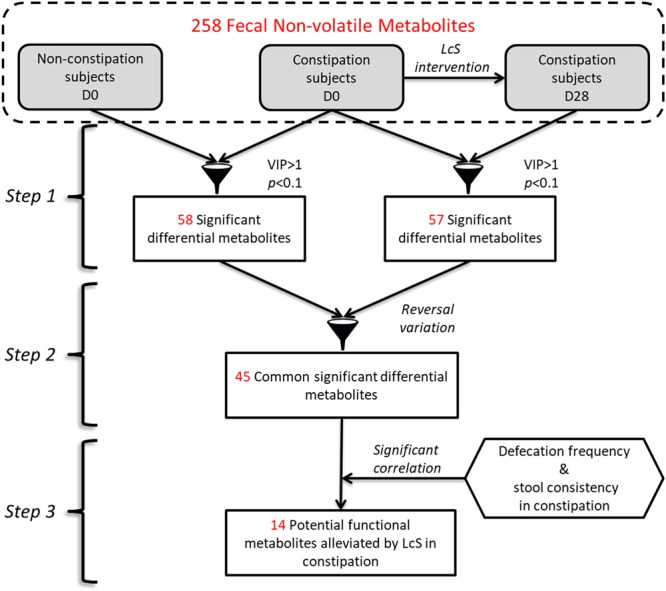
The workflow of determination of potential functional non-volatile fecal metabolites involved in constipation alleviation by LcS.